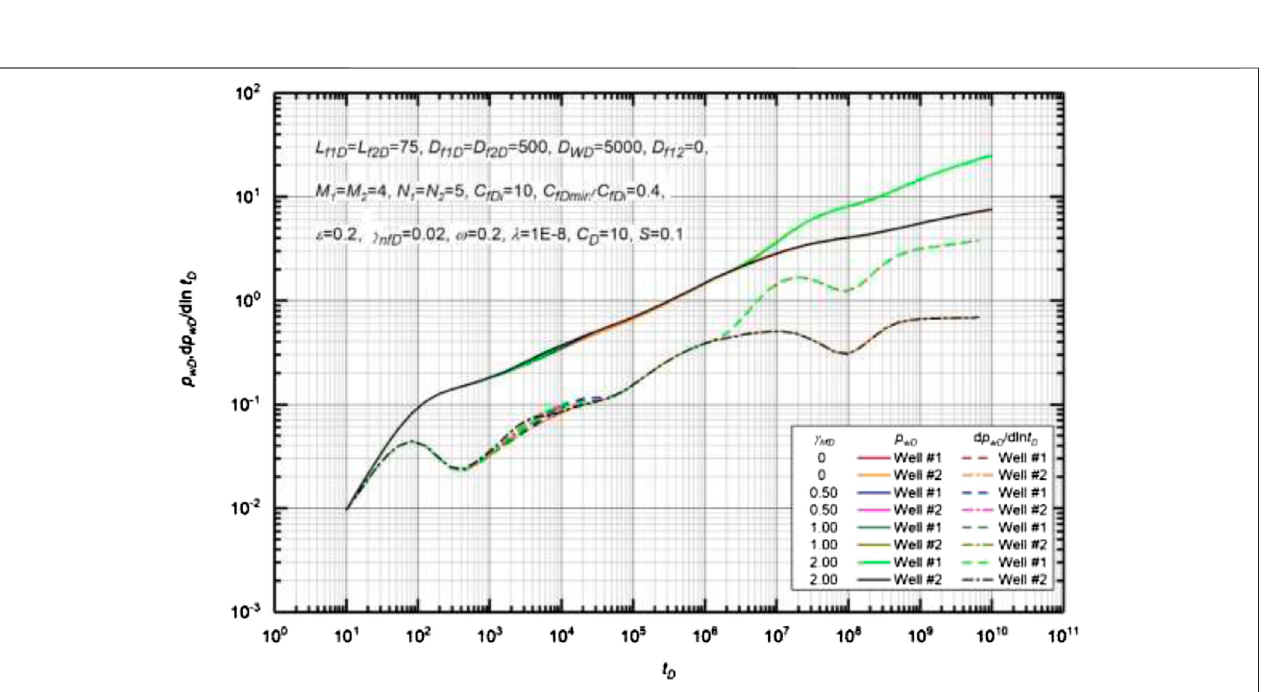
Frontiers in Energy Research |